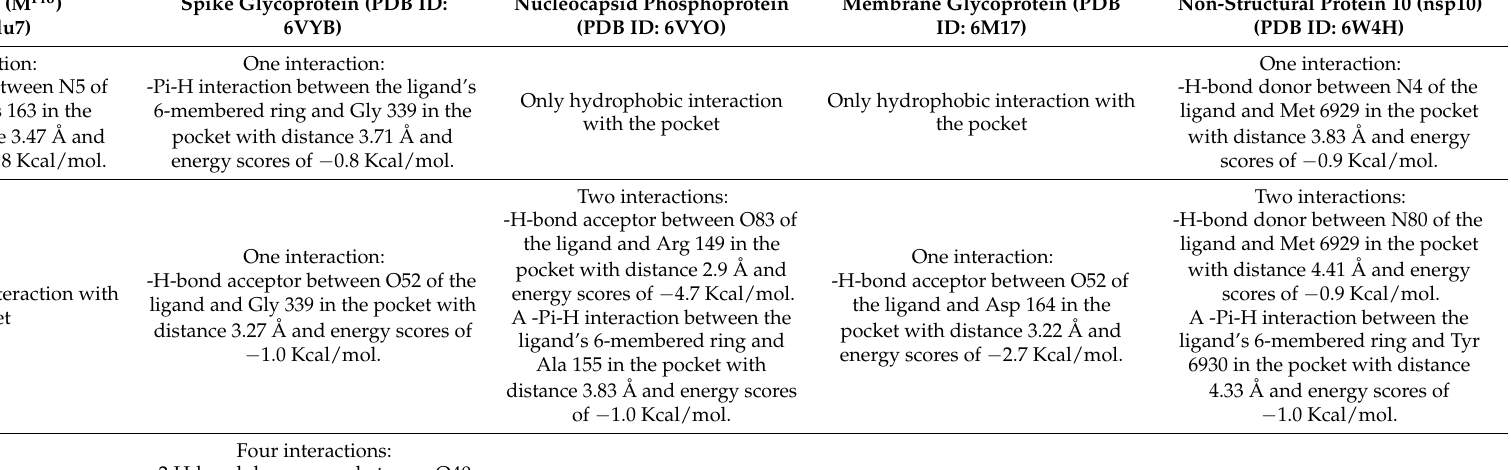
Table 2. The 2D interactions of compounds in the screening library compared to those of native co-crystallized ligands with the five SARS-CoV-2 target proteins.